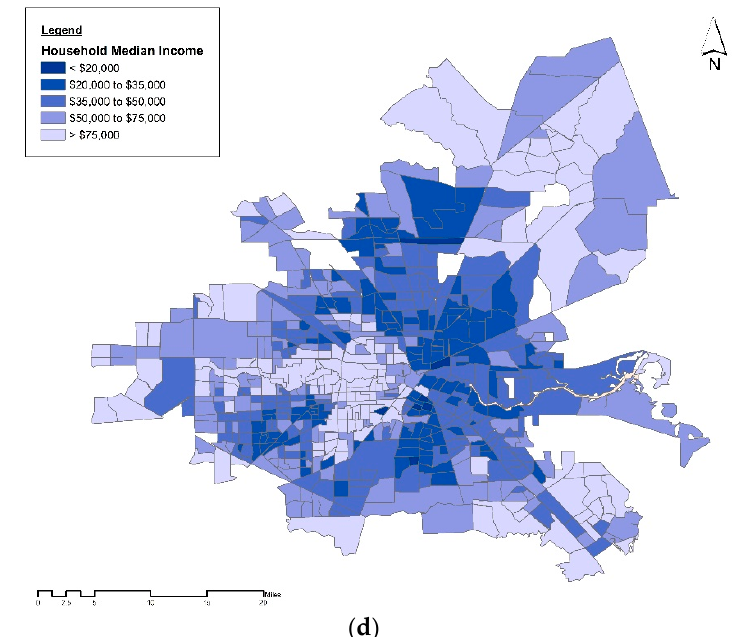
Figure 4. Spatial variation of ( a ) percentage of premature deaths attributable to PM 2.5 from all ‐ cause deaths, ( b ) percentage of premature deaths attributable to NO 2 from all ‐ cause deaths across the city of Houston at the census tract level, in 2010. Spatial variation of ( c ) vehicle mile traveled per area, and ( d ) median household income across the city of Houston at the census tract level, in 2010.